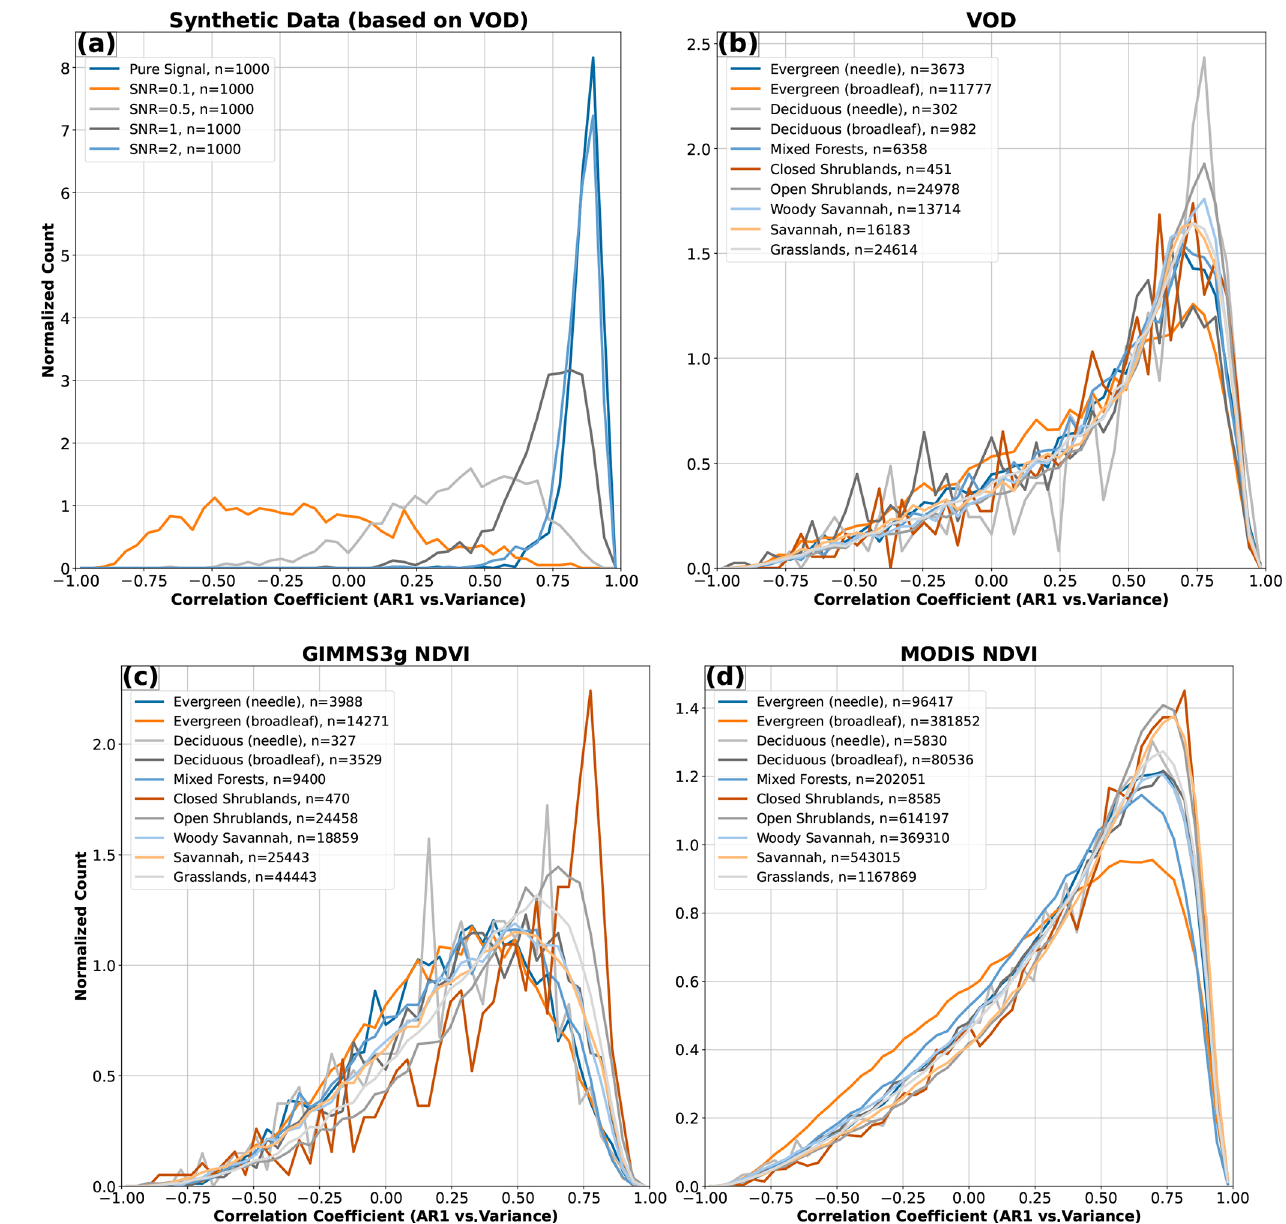
Figure 4. Distribution of correlation coefficients between AR1 and variance computed for individual time series. (a) Synthetic data based on the vegetation optical depth (VOD) data for different signal-to-noise ratios (SNRs), (b) VOD data, (c) GIMMS3g normalized difference vegetation index (NDVI), and (d) MODIS NDVI. AR1 and variance are calculated on a 5-year rolling window pixel-wise (satellite data) and for n = 1000 synthetic time series. Each panel has 50 equally spaced bins from − 1 to 1. For (a) , four different SNRs are shown, as well as the underlying signal (i.e., without the influence of a changing measurement noise). For (b–d) , pixels are divided by land-cover type. The distribution of correlation coefficients is generally positive, except in the synthetic approach with low